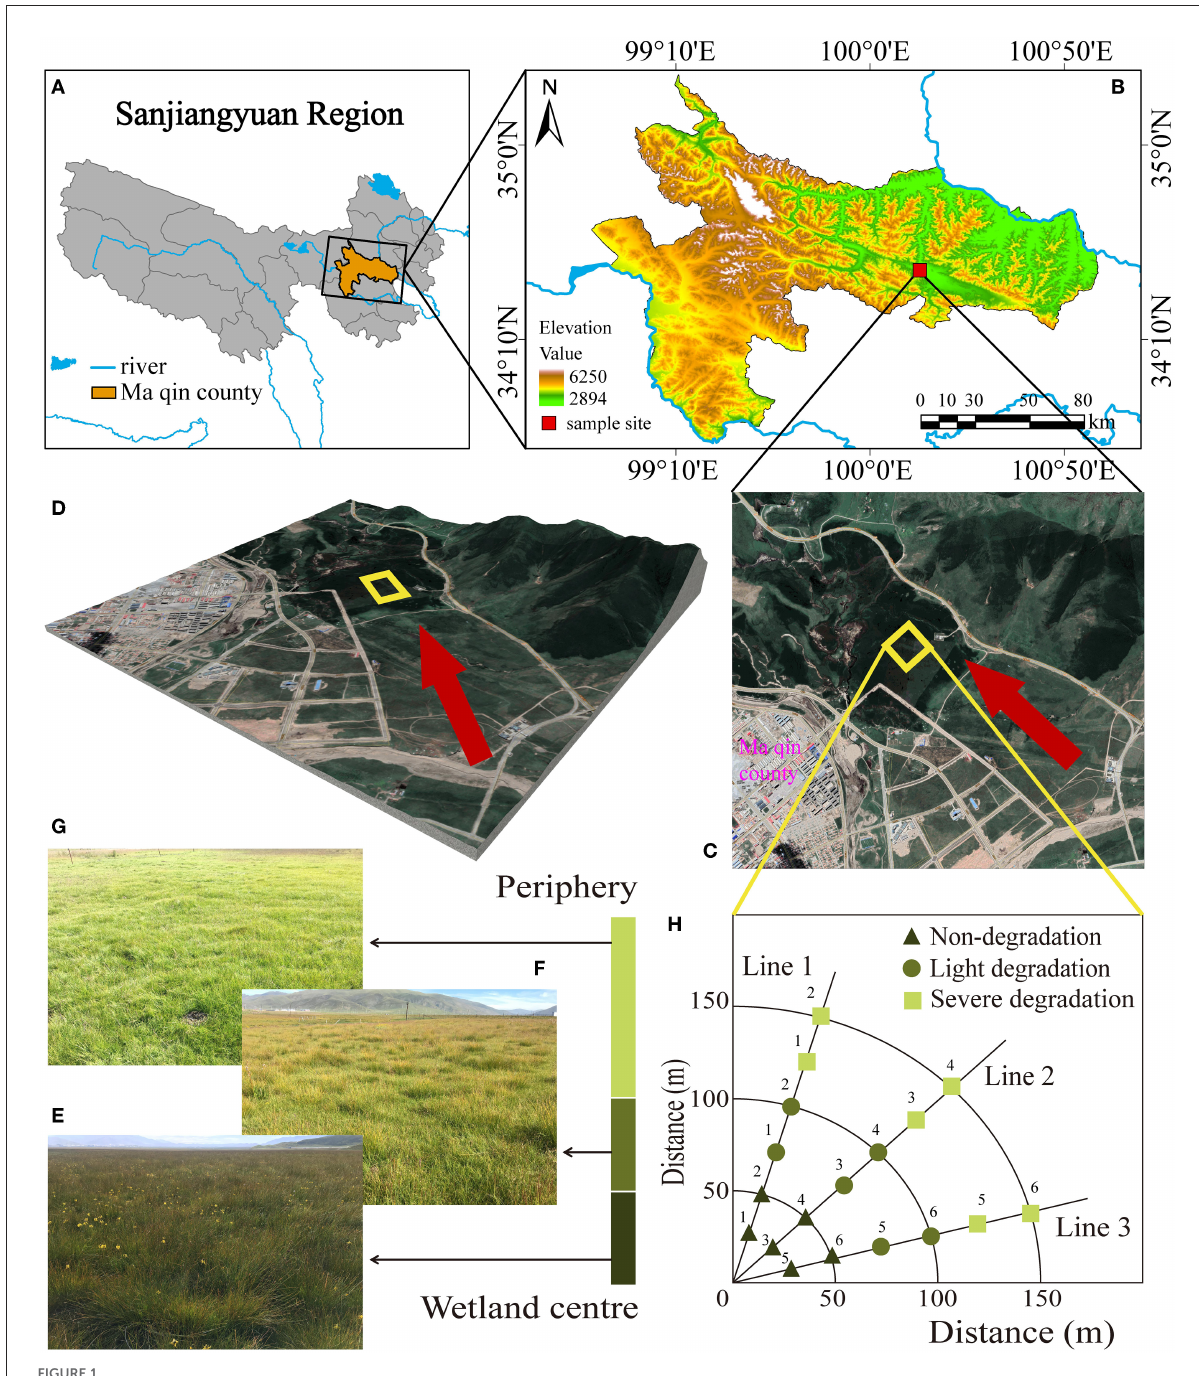
FIGURE1 Location of the study site and the experiment sites and treatments. (A) Sanjiangyuan area, (B) the study area, (C) sampling site, (D) 3D view, (E) non-degraded the alpine wetland landscape, (F) light degraded the alpine wetland landscape, (G) severe degraded the alpine wetland landscape, and (H) the distribution of sampling points.